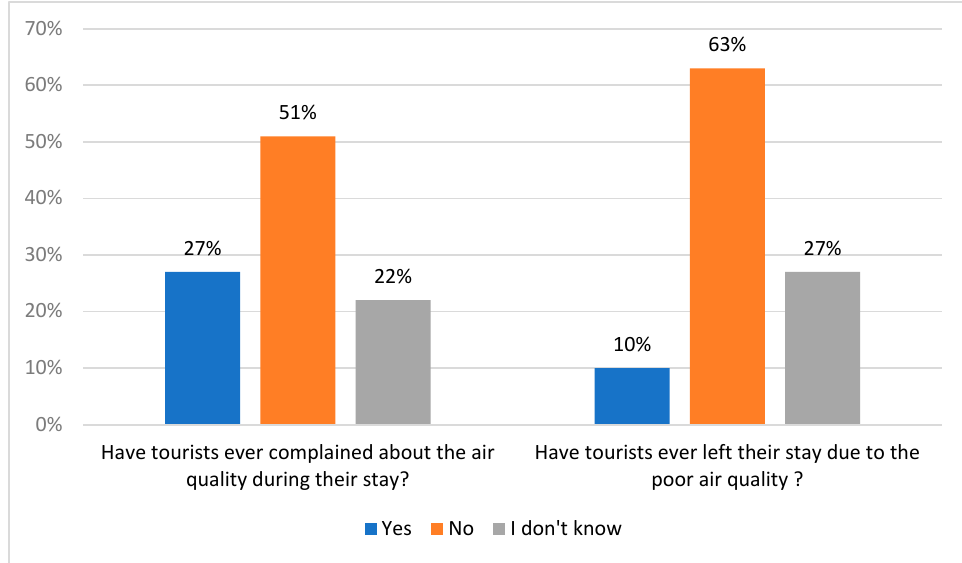
Figure 14. Consequences of air pollution for tourists’ stays in view of the respondents’ experiences. Source: own study.